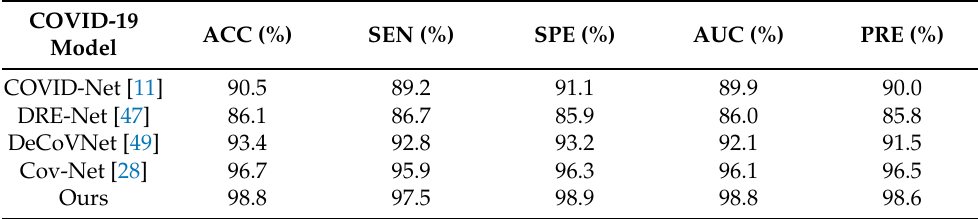
Table 8. Comparison of our proposed model with famous pre-trained feature extraction models for multi-class using the dataset.